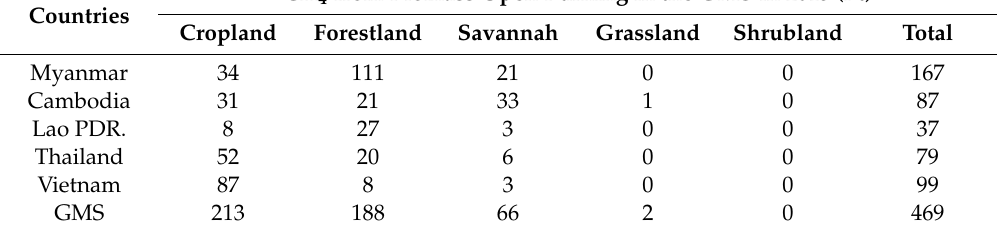
Table A2. The actual amount of CH 4 from biomass open burning classified by vegetation types in the GMS in 2015.